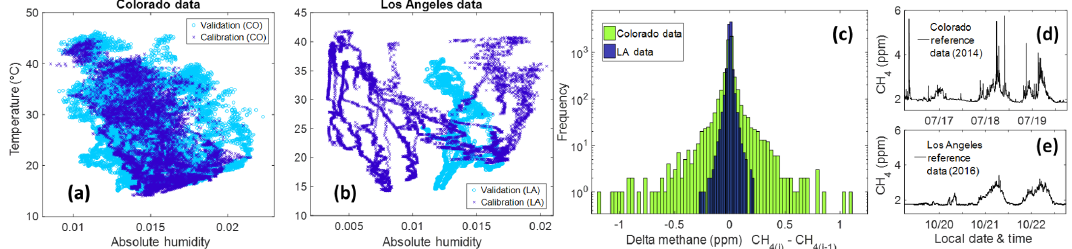
Figure 6. Panels (a) and (b) are the temperature and humidity values observed during calibration and validation periods in Colorado and Los Angeles, respectively. Panel (c) is a histogram of the changes in methane from minute to minute (for the reference data) and panels (d) and (e) are 3 days of minute-resolution data from the reference instruments in Colorado and Los Angeles,